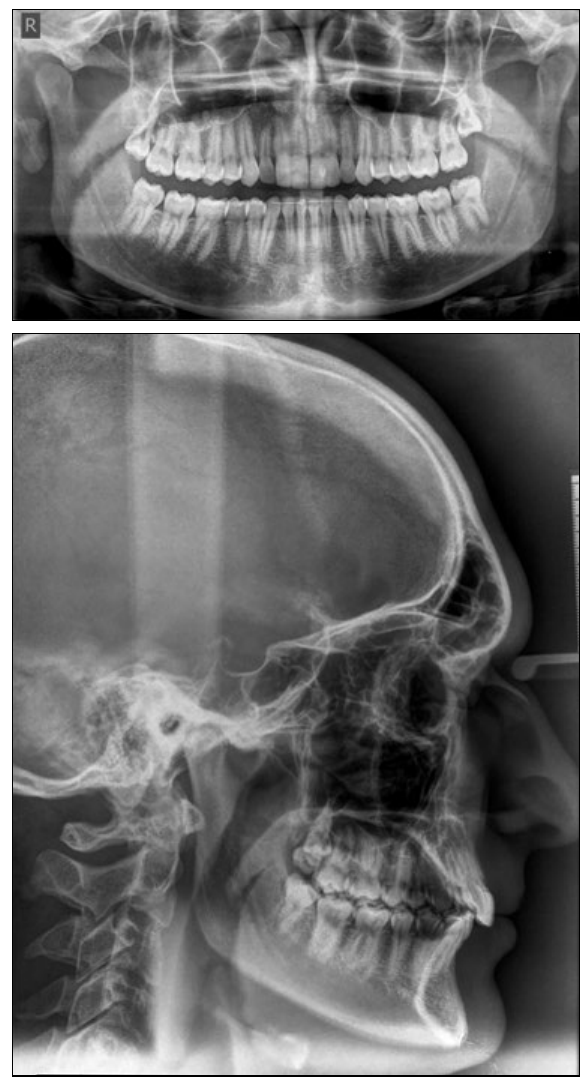
Figure 11, 12. The post-treatment radiographic evaluation included a panoramic and a lateral cephalometric